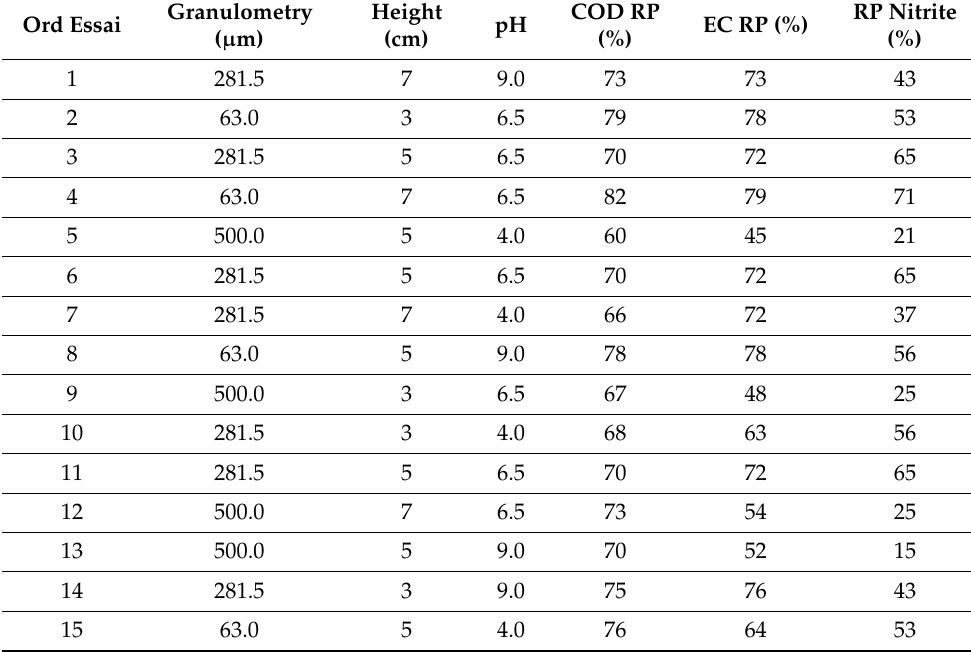
Table 1. Experimental matrix with measured